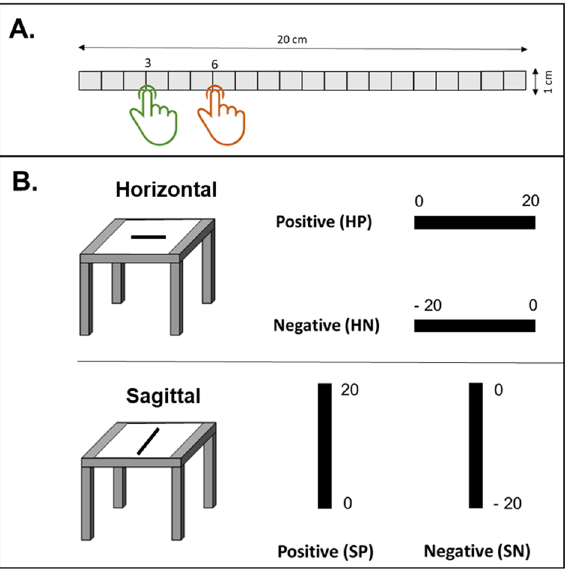
Figure 1. ( A ) Haptic number-to-position task. On each trial, children were required to localize numbers on a metal rule, and deviation from true numbers’ position was calculated in terms of PE (percentage of error) and PAE (percentage of absolute error). ( B ) Task conditions. The task comprised four task conditions depending on rule position on the table (horizontal or sagittal) and on number polarity (positive or negative). HP: horizontal number line with positive numbers increasing from left to right; HN: horizontal number line with negative numbers decreasing from left to right; SP: sagittal number line with positive numbers increasing from bottom to top; SN: sagittal number line with negative numbers decreasing from bottom to